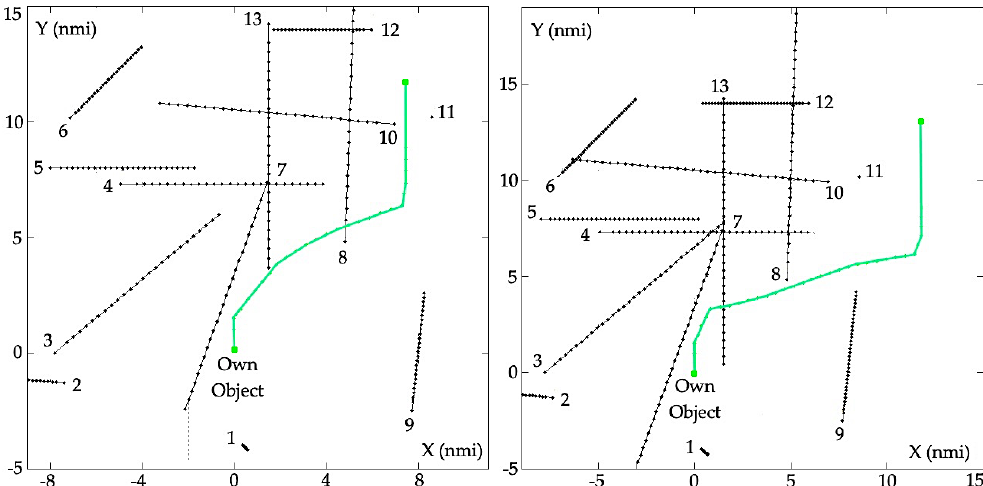
Figure 11. Object game trajectories calculated according to the mg c algorithm of cooperative matrix game control: on the left — with good visibility at sea, with the final payoff of the game ε f = 7.4 nmi achieved, assessing deviation safe trajectory from reference cruise route; on the right — with limited visibility at sea, with the final payoff of the game ε f = 12.1